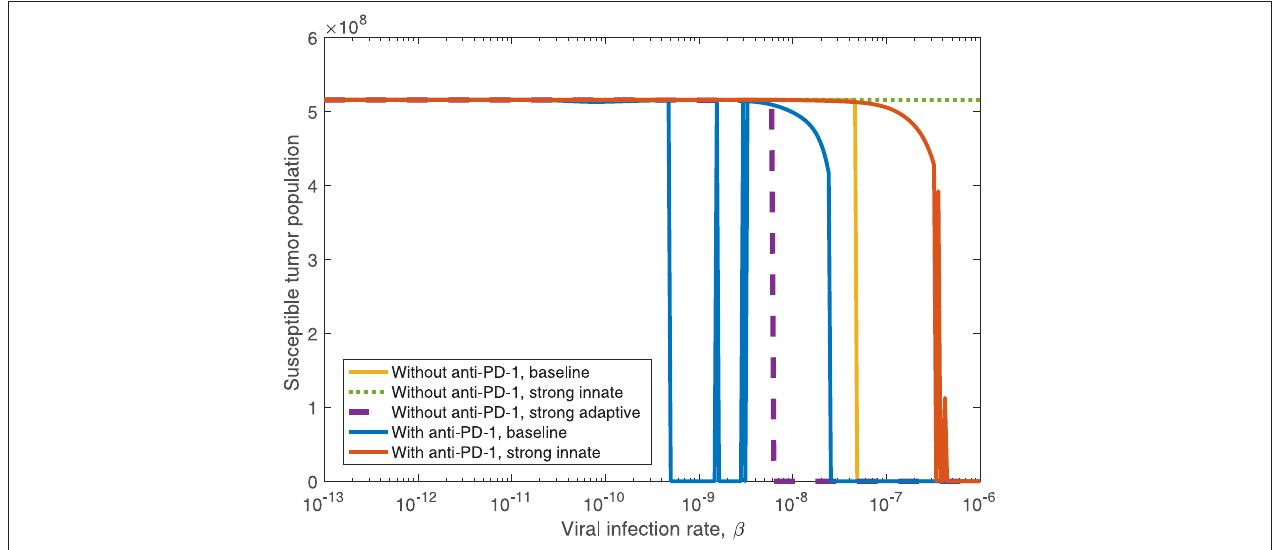
FIGURE 10 | The susceptible tumor population after 3,000 h as the viral infection rate, β varies. The susceptible population is shown both with and without anti-PD-1, and we compare between a baseline tumor and a tumor with strong innate or a strong adaptive immune system. In the strong innate case, k VZ = 2 and s ZR = 0.2. In the strong adaptive case, a AT =